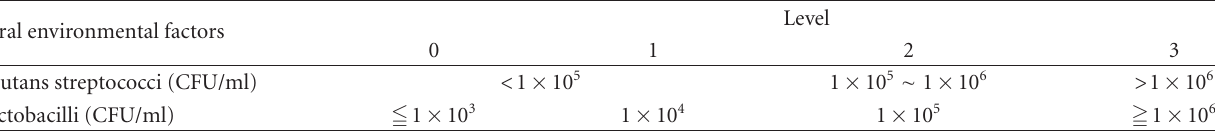
Table 1: Classification of oral environmental factors.